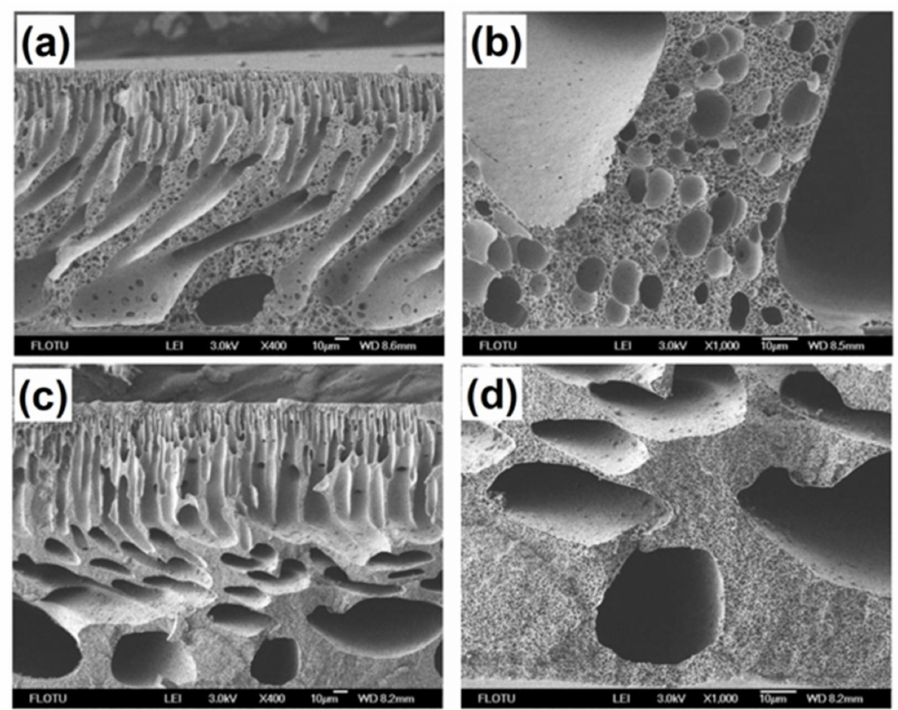
Figure 7. SEM photomicrographs of cross-sections of PPSU UF membranes prepared with: ( a , b ) PVP- 15000; ( c , d ) PEG-6000 as a polymeric pore-forming